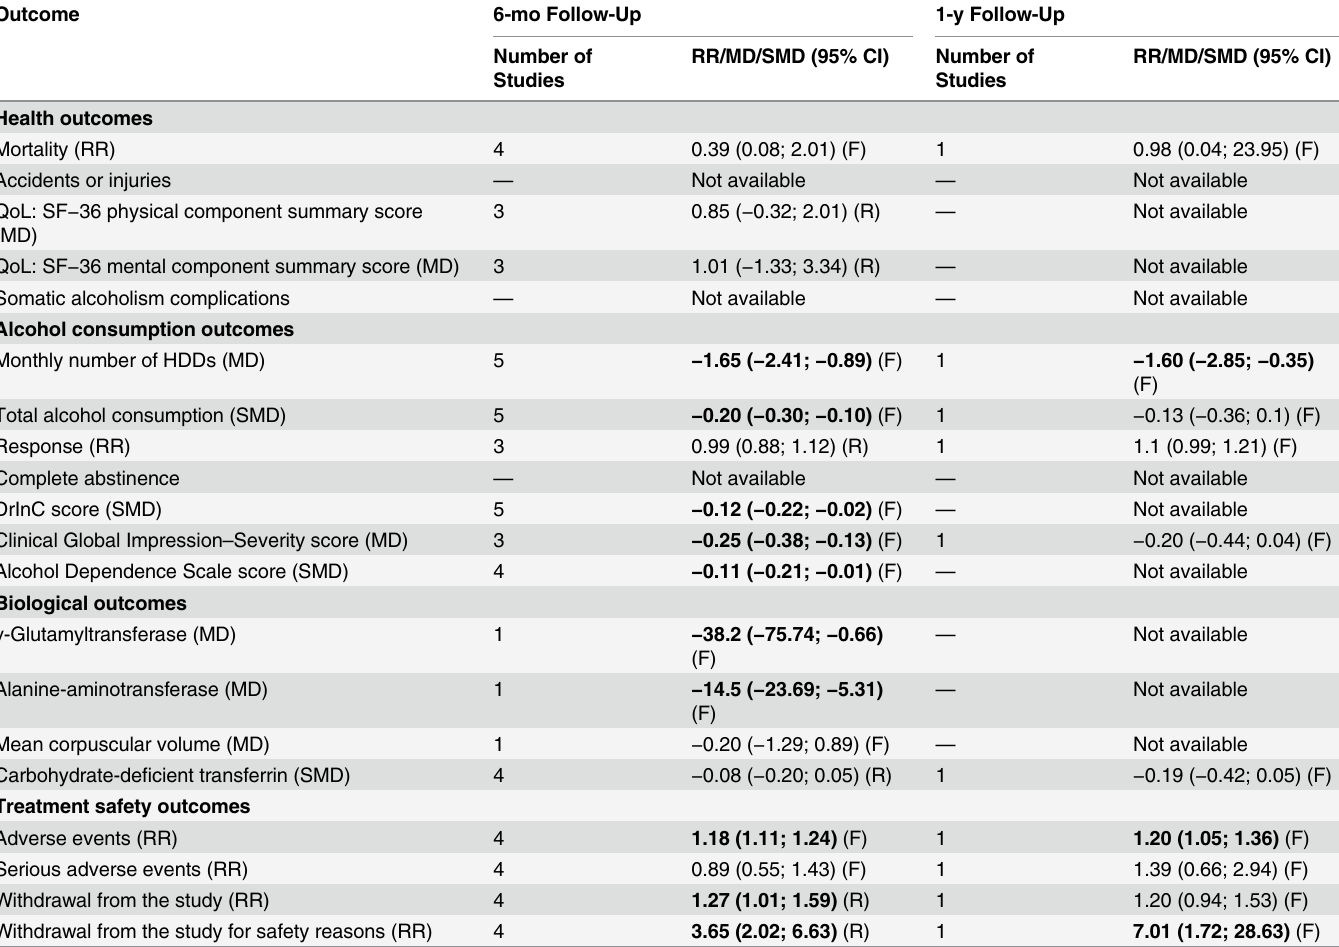
Table 3. Summary of findings from trials assessing efficacy of nalmefene in the treatment of adult alcohol dependence.